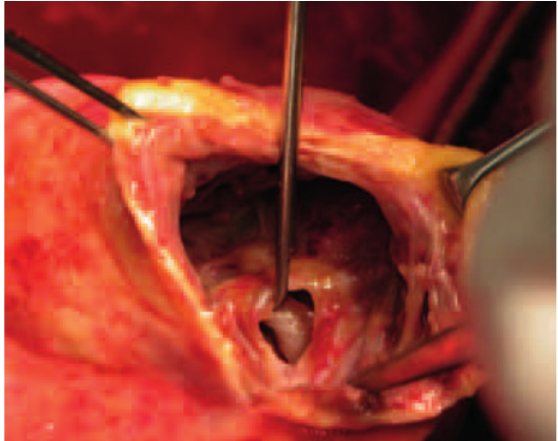
Figure 3. Intraoperative fi nding of postinfarction ventricular septum defect in the apical